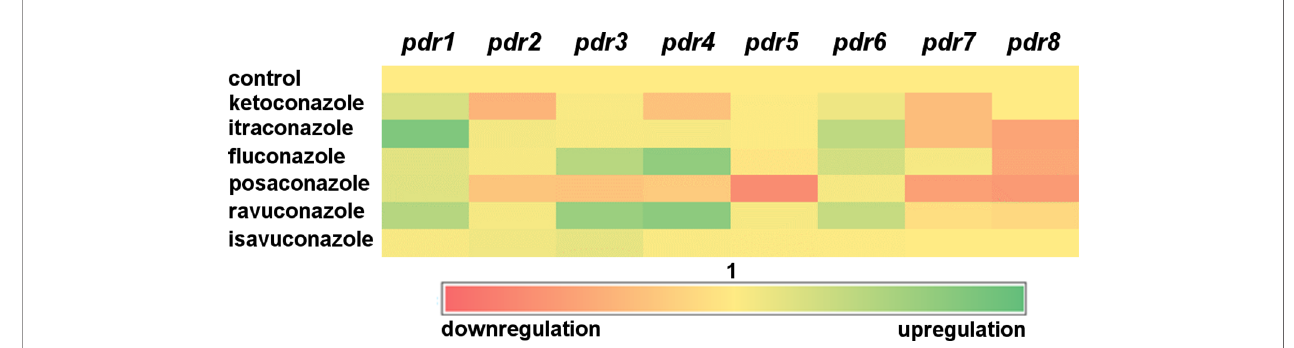
FIGURE 3 | Heat-map of transcript level of pdr genes in response to exposure to azoles. Red and green colors indicate down- and upregulation, respectively, while yellow corresponds to the transcription activity of the control.